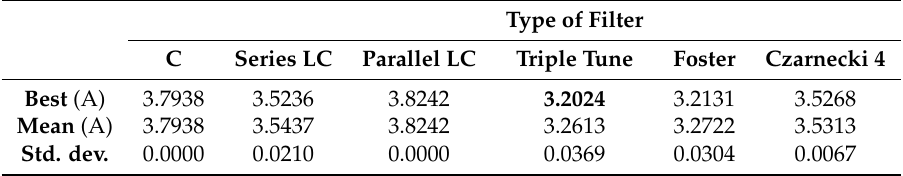
Table 3. Compensated RMS current ( I scp ) obtained by the genetic algorithm in Castilla’s case study